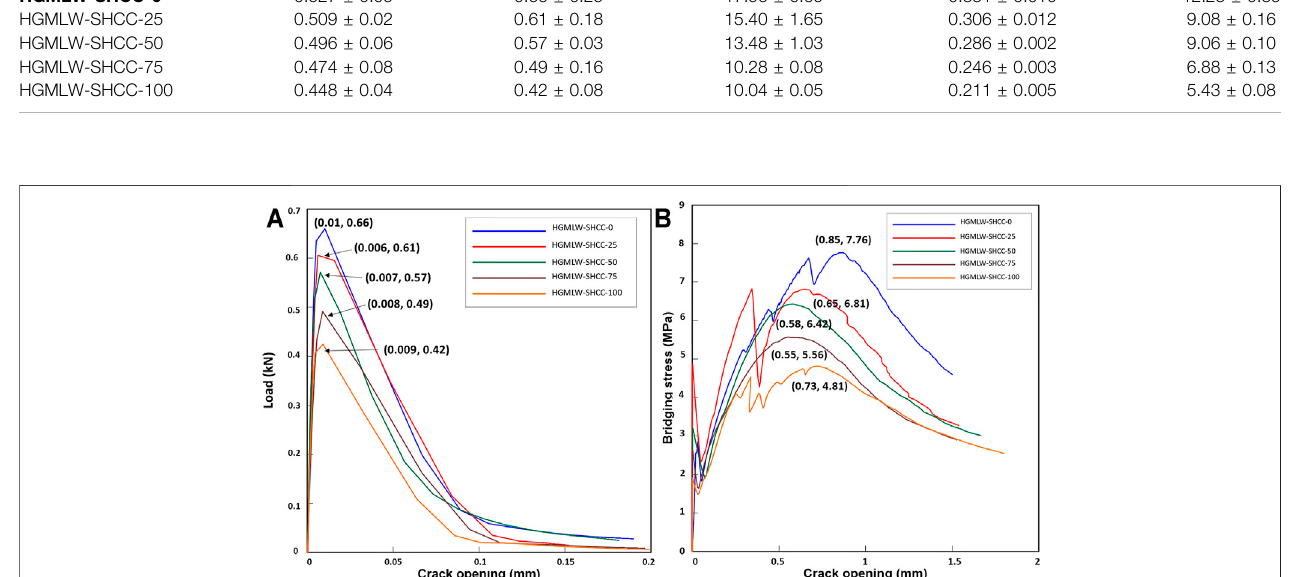
FIGURE 9 | Average results of (A) of crack mouth opening displacement; (B) Single-crack tensile test.